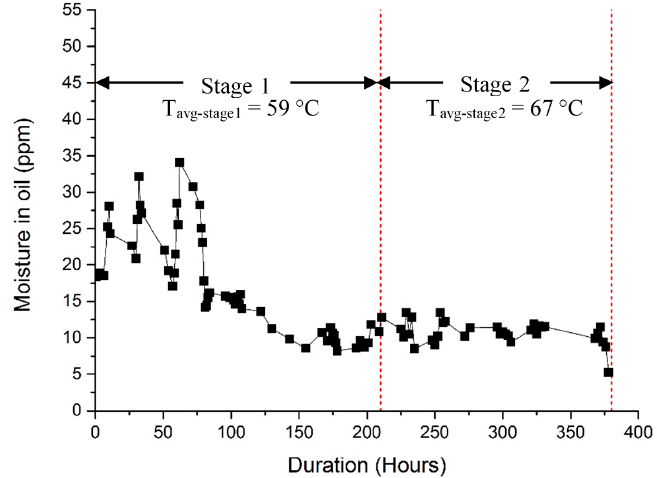
Figure 6. Moisture in oil profile during the regeneration experiment.